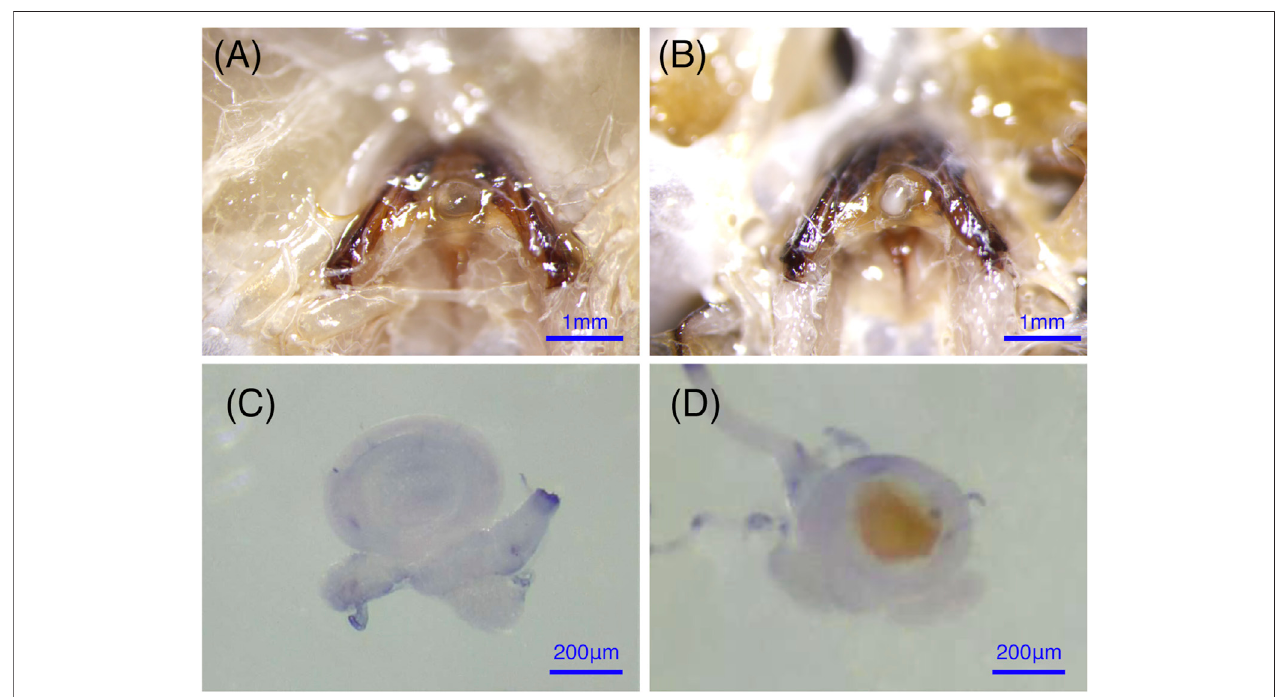
FIGURE1| Theanatomicalstructure ofthespermathecae invirginand mated bumblebeequeens. (A) and (C) show thatthespermathecaeofthevirgin queen are empty and almost translucent. (B) and (D) show that the mated queens spermathecae is fi lled with semen.